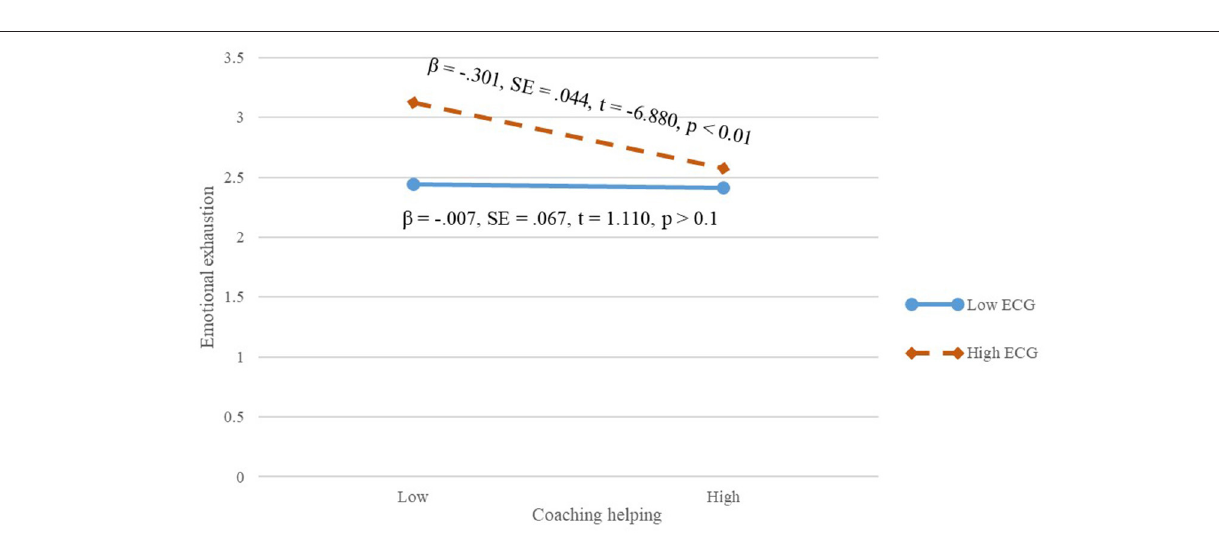
FIGURE 3 | Interactive effect of extrinsic career goals on the relationship between coaching helping and employees’ emotional